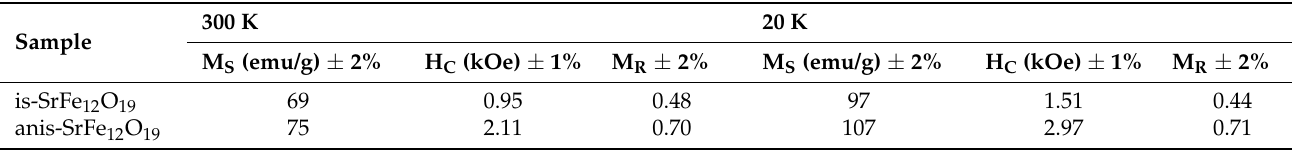
Table 5. Saturation magnetization M S , coercivity H C and squareness parameter M R , at T = 300 K and 20 K, for the samples labeled as indicated in column 1.